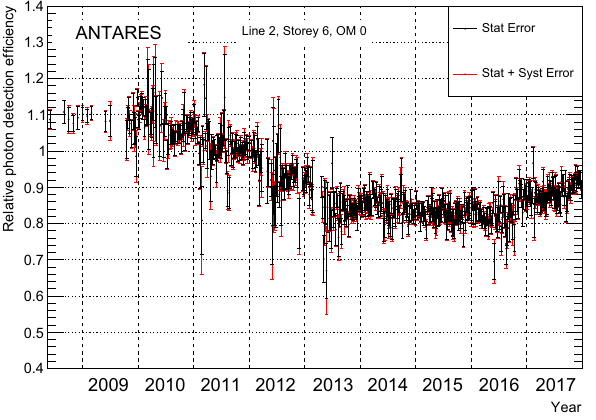
Fig. 3 Photon detection efficiency as a function of time for one ANTARES OM (Line 2, Storey 6, OM 0). Error bars correspond to statistical (black) and statistical plus systematic (red) contributions